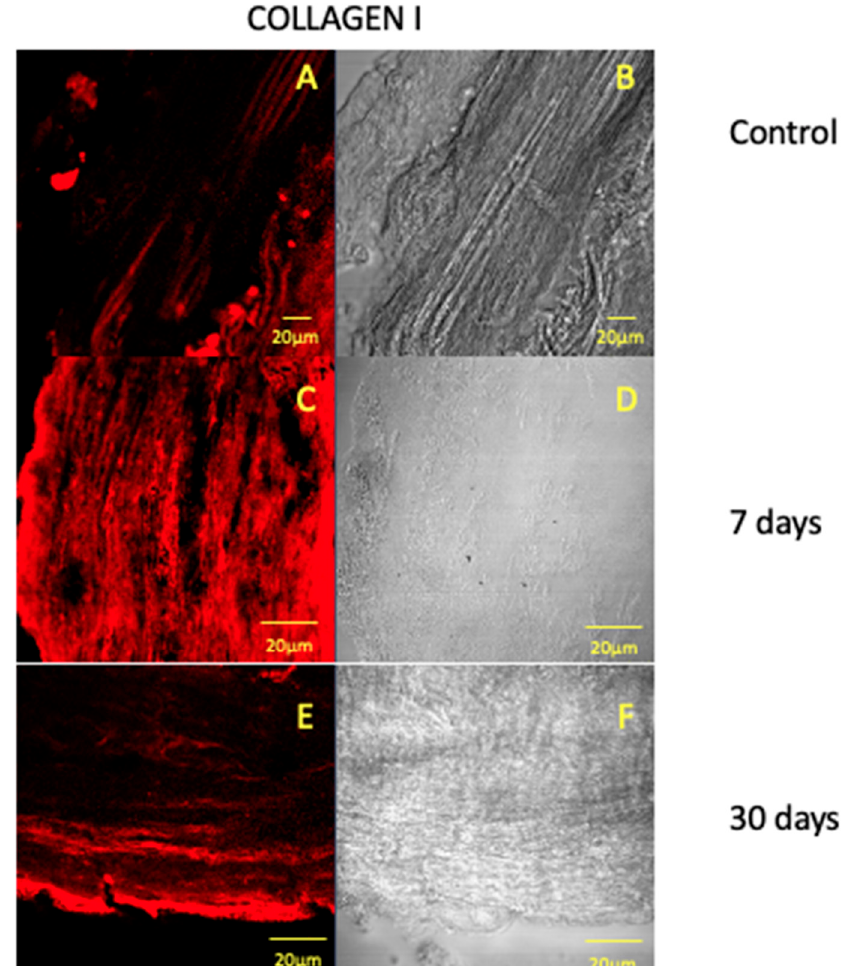
Figure 2. Compound panel of immunofluorescence reaction pictures that show collagen I staining pattern (red channel) in human dental pulp after 7 ( A ), 14 ( C ) and 30 ( E ) days after pre-calibrated force application and the corresponding transmitted light observations ( B , D , F ). The following magnifications have been used: 40 × ( A , B ), 20 × ( C , D , E , F ).